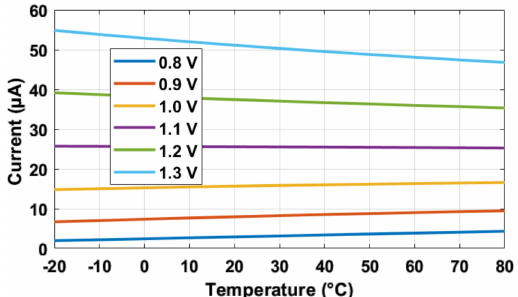
Figure 14. Simulation results of the current in an nMOS transistor biased with constant V GS voltage: when V GS increases from 0.8 V to 1.3 V, its current’s temperature coefficient goes from positive to